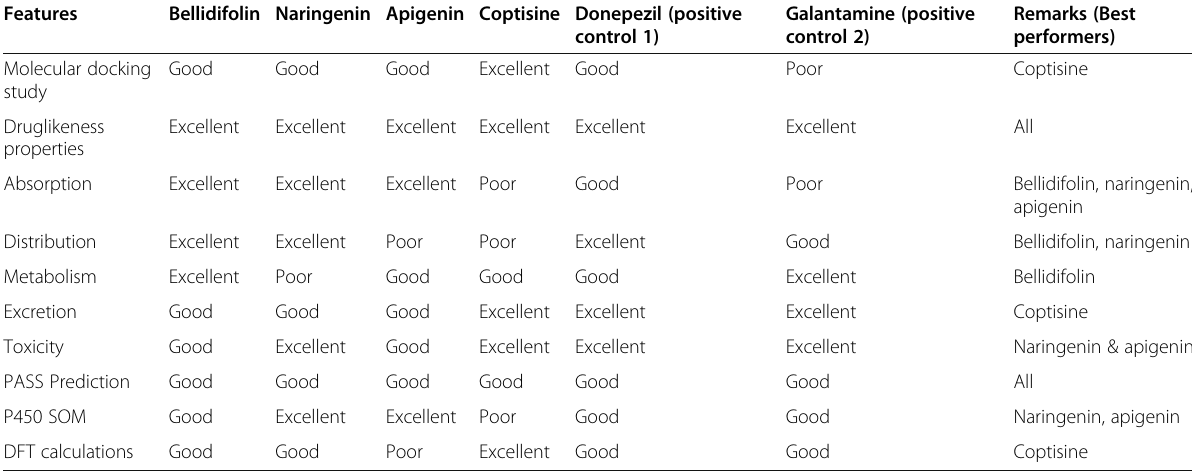
Table 10 Overall comparison of the main features of bellidifolin, naringenin, apigenin, and coptisine as potential drugs to treat AD according to the study along with the 2 positive controls from comparison. All the compounds are ranked (excellent, good, and poor) based on their performance in every aspect